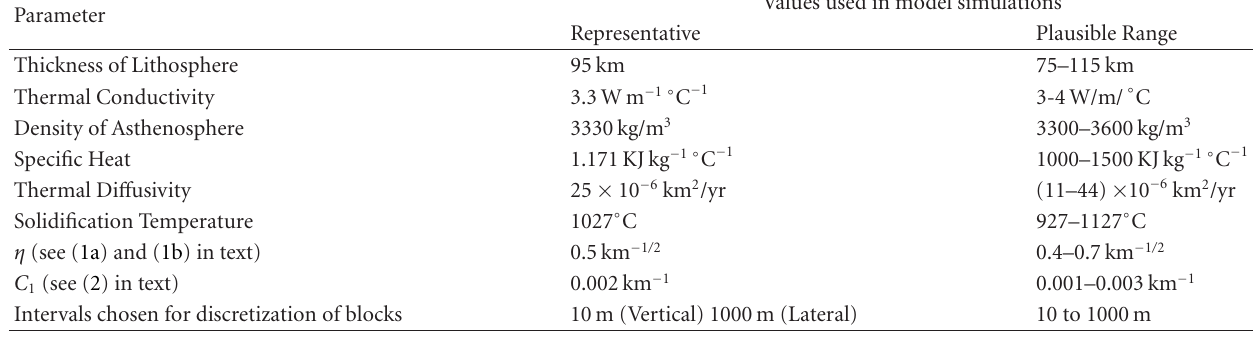
Table 1: Values of parameters used in numerical simulations of the VBA model of the oceanic lithosphere.